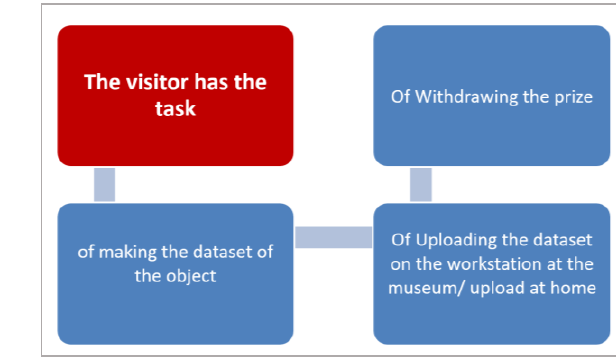
Figure 20. The big sculptures category